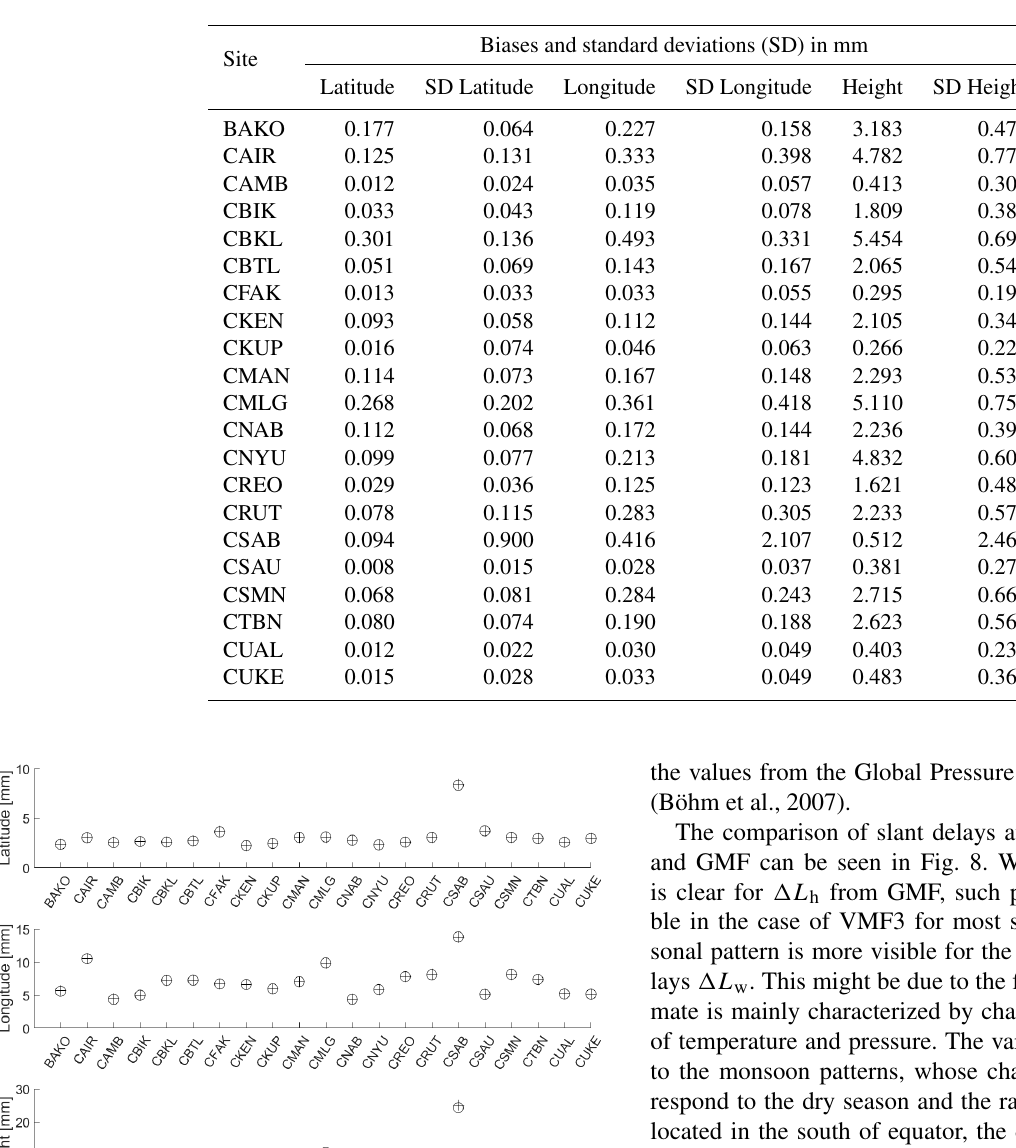
Table 2. Mean absolute biases and standard deviations for VMF3 and VMF1.